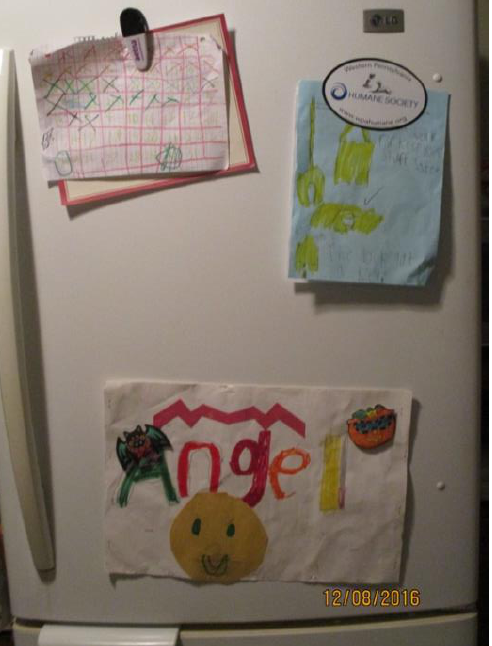
Roberto Boyzo, Children’s Drawings on the Fridge , Digital photograph, December 5, 2016. Courtesy of Héctor Camilo Ruiz